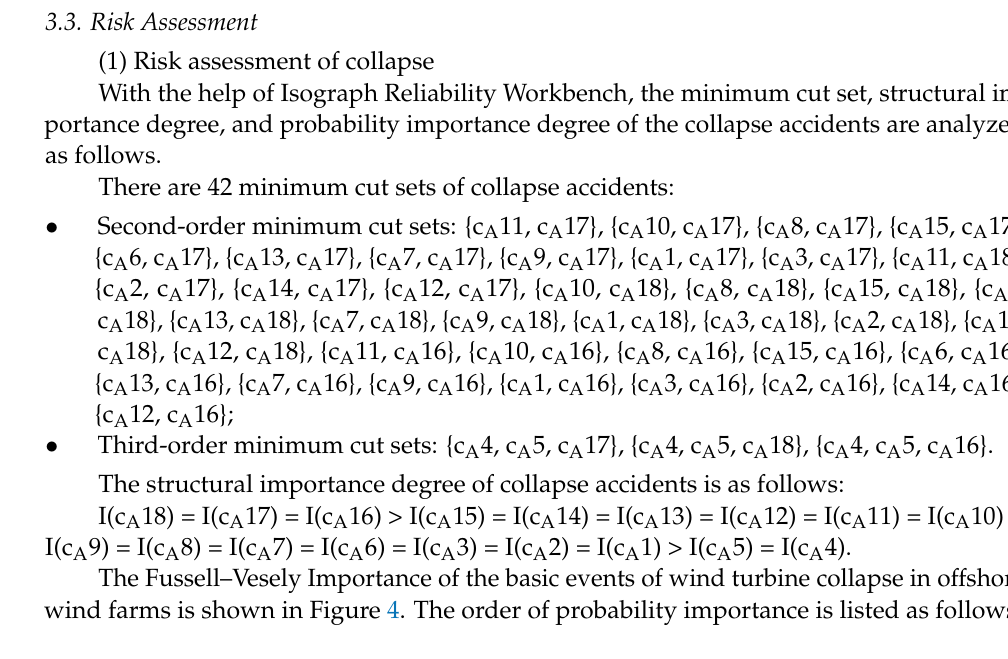
Figure 3. Fault tree analysis model for corrosion risk of the offshore wind farm.